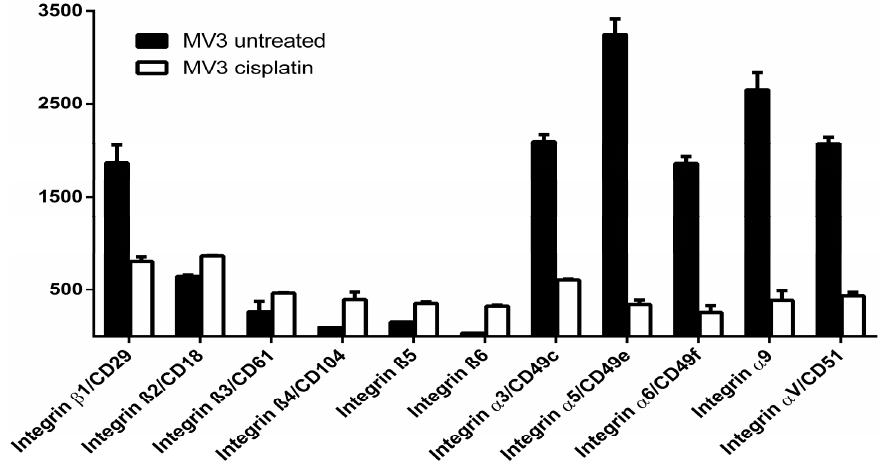
Figure 2. Integrin expression pattern of MV3 melanoma cells and the impact of cisplatin treatment. Cells were incubated for 72 h in the presence of cisplatin (IC 50 ) (white) and then washed twice with PBS (phosphate buffered saline) to exclude dead cells before being submitted to proteome profiler array compared to untreated cells (black). The array revealed a strong decrease in a great variety of proteins (data not shown) and a shift in integrin distribution among its subunits representing one of only a few up regulations in proteins, under cisplatin treatment. All α -chains of integrins investigated were strongly down-regulated, while the ratio of β -chain containing integrins was, with exception of β 1, up-regulated. β 1 and α 3 are known to be receptors binding to collagen. The decrease of collagen binding integrins and shift to other integrin subtypes serves as first hallmark for the observed differences in integrin activation. Measurements were conducted in duplicates ( n = 2). The individual differences between the two measurements were mostly below 10%.